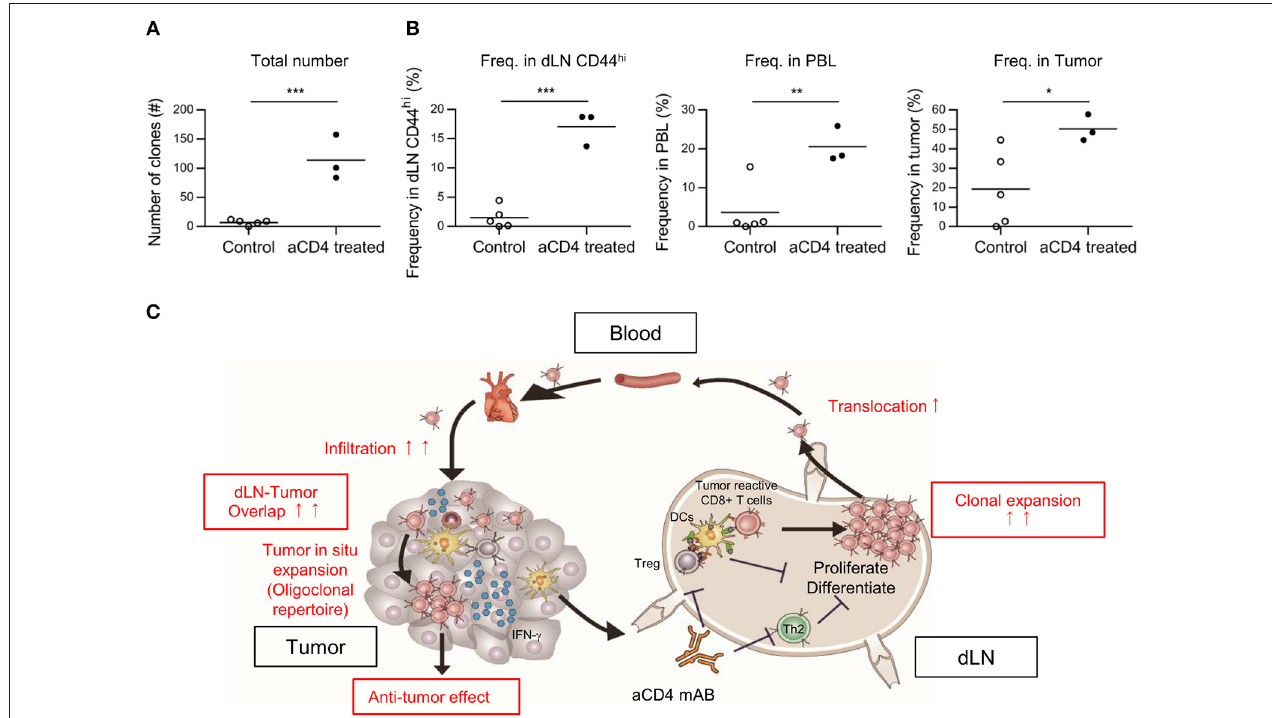
FIGURE 7 | Anti-CD4 mAb treatment enhanced the translocation of tumor infiltrating clones between the dLN, the PBL, and the tumor. Mice bearing B16F10 tumors were injected i.p. with anti-CD4 mAb on days 5 and 9, and analyzed on day 14 after tumor inoculation. (A,B) Overlapping clones among the dLN CD44 hi , PBL, and tumor, which were putative tumor-reactive clones. The total number (A) and combined frequency in the dLN CD44 hi ( B , left), PBL ( B , middle), and tumor ( B , right) are compared. (C) Schema of the hypothesis for the mechanism underlying the antitumor effect of anti-CD4 mAb treatment based on TCR repertoire analysis. (A,B) present the data for TCR. Two-sided unpaired Student’s t -tests ( n = 3 for aCD4, and n = 5 for control). * P < 0.05; ** P < 0.01; *** P <